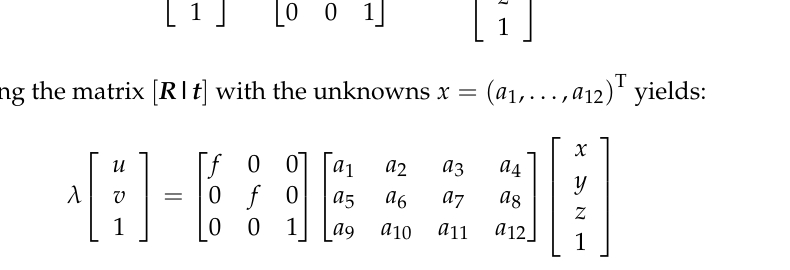
The projection plane point set Q uses normalized coordinates, ignores the effect of the internal reference matrix K , and simplifies the transformation matrix T to the augmented matrix. Then, the target point is projected from the spatial coordinate system (world coordinate system) into the projection plane coordinate system, which can be expressed as: